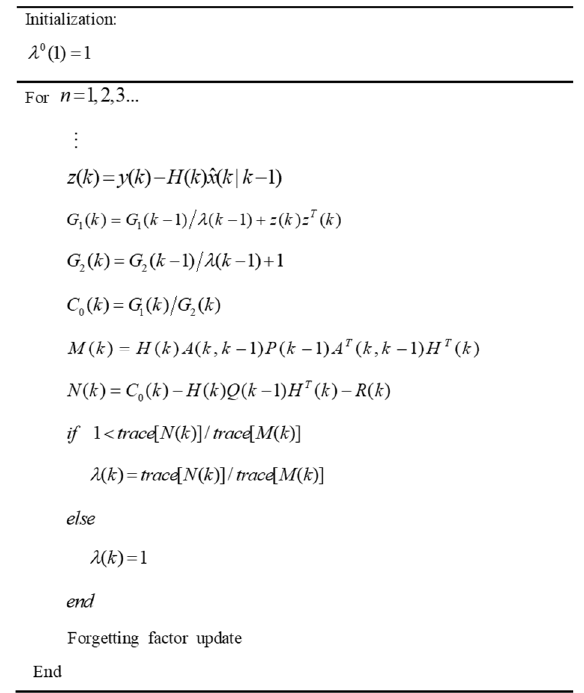
Figure 3. The pseudo-code for the forgetting factor update ( P -adaptation loop)